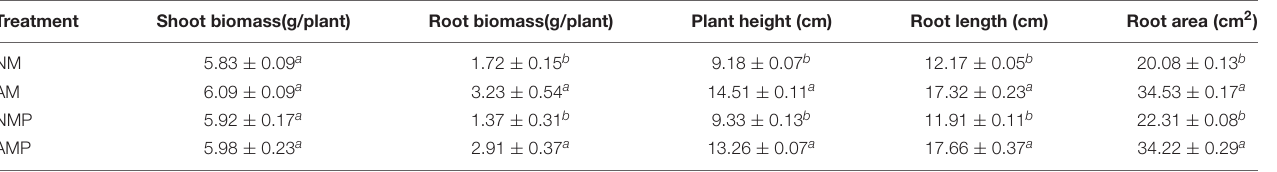
FIGURE 2 | Disease incidence (A) and disease index (B) of common vetch anthracnose under arbuscular mycorrhizal and disease treatments. NM = uninoculated with S. tortuosa , AM = inoculated with S. tortuosa , NMP = NM inoculated with C. lentis , and AMP = AM inoculated with C. lentis . Different lowercase letters on the bars means there is significant difference across treatments at P < 0 . 05 by Tukey’s HSD test. TABLE 1 | Effects of AM fungus S. tortuosa and C. lentis on the growth of common vetch. Treatment Shoot biomass(g/plant) Root biomass(g/plant) Plant height (cm) Root length (cm) Root area (cm 2